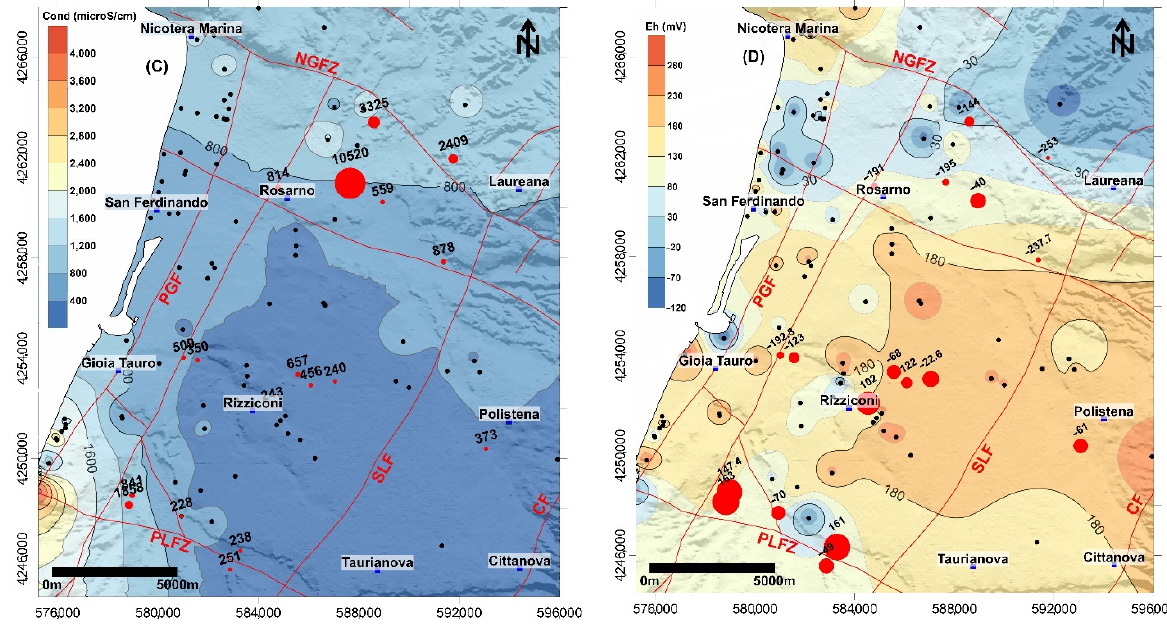
Figure 9. Iso-concentration maps of ( A ) temperature, ( B ) pH, ( C ) conductivity and ( D ) Eh reconstructed for the HU3 shallow aquifer by using the Inverse Distance Weighting (IDW) as spatial interpolation method. Red line, black and red circles represent the main faults, phreatic and artesian wells (HU1 aquifer), respectively. For each artesian well, the respective physical-chemical value measured in the field is reported (dot size increases with the parameter value).